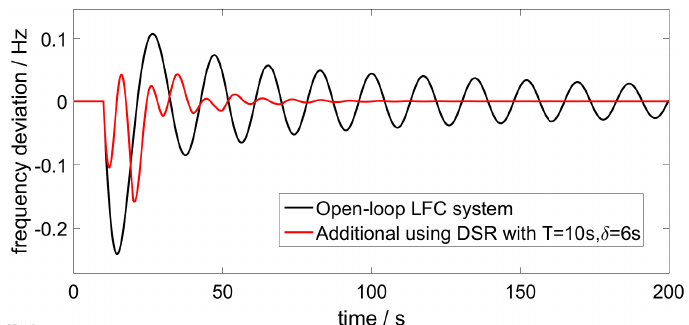
Figure 8. Frequency deviation under open-loop and close-loop LFC system in area 1.